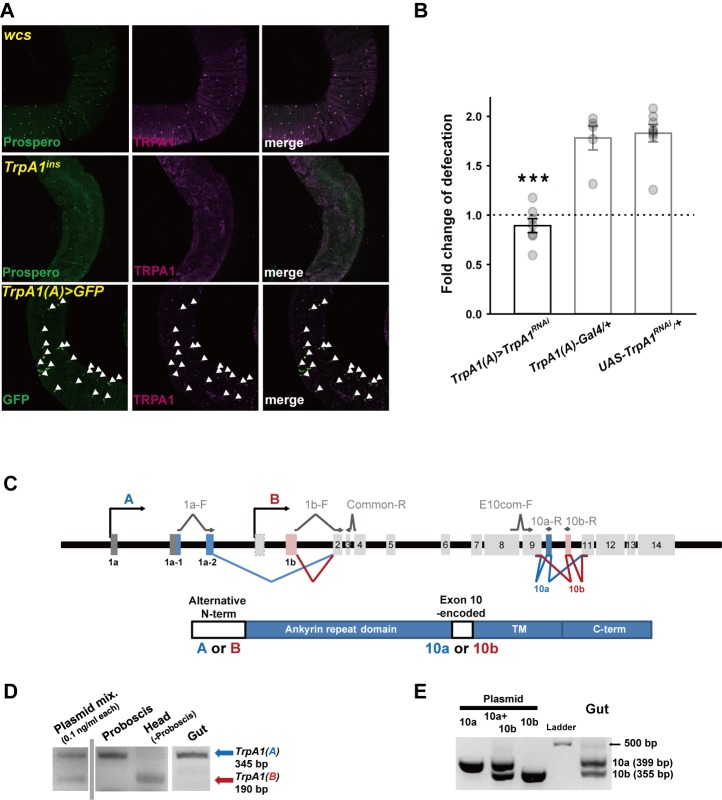
TrpA1(A) in a subset of enteroendocrine cells is necessary for uracil-dependent defecation.A Co-immunostaining of TRPA1 and either Prospero or GFP in the anterior midgut from indicated genotypes. Bottom, Arrowheads: TRPA1 and GFP co-immunostaining. B
TrpA1 RNAi in TrpA1(A)-Gal4 EECs dramatically suppresses uracil-dependent defecation (n = 5–8). C
TrpA1 gene structure illustrating alternative exon usage (Top) and TRPA1 protein organization showing variable domains (Bottom). The primers used in reverse transcription PCR analyses shown in (D and E) are indicated as arrows. Most of primers in these analyses were designed to straddle two separate exons in order to prevent PCR amplification of genomic DNA. D and E The representative results of RT-PCR analyzing alternative exons of TrpA1 transcripts in the gut for the N-terminal (D) and exon10-encoded domains (E). ‘Plasmid’ indicates the PCR reactions with cloned cDNAs of TrpA1 transcripts as DNA polymerization templates, and the bands resulting from the‘plasmid’ reaction were used as size and intensity markers. Proboscis, Head and Gut denote the tissues where total RNA was prepared for reverse transcription. The band of the “Ladder” lane is a 500 bp long DNA fragment of Generuler 1 kb ladder (E). 10a and 10b indicate cDNA templates or PCR products of TrpA1(A)10a and TrpA1(A)10b, respectively, and the PCR products from the template of cloned cDNA (indicated by ‘Plasmid’) serve as size markers for the RT-PCR experiments with total cDNA prepared from the gut. Bar graphs show mean ± SEM with distribution. ***: p<0.001, Tukey test.